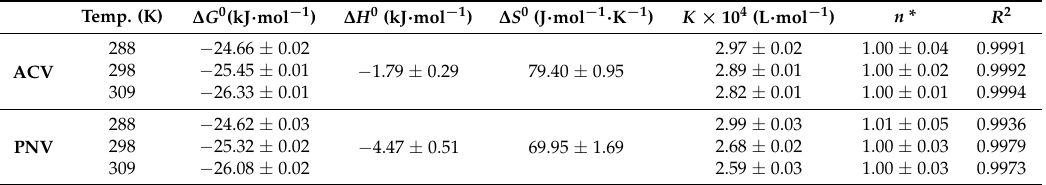
Figure 5. Van’t Hoff plots for ( a ) ACV-HSA and ( b ) PNV-HSA complexes. Table 2. Thermodynamic parameters and binding data for the ACV/PNV-HSA interactions. Temp. ( K )